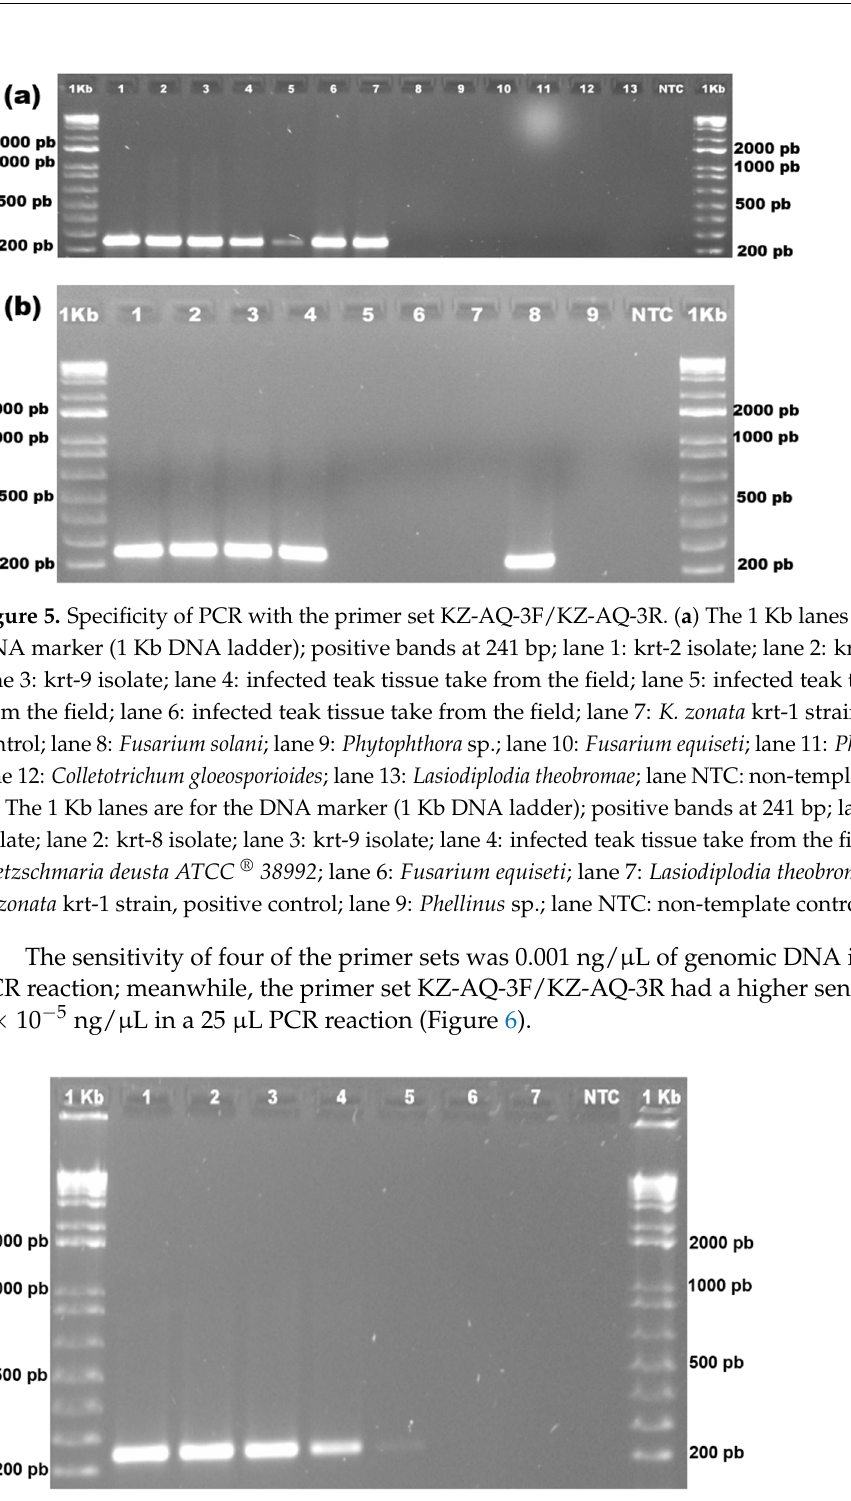
Figure 6. PCR sensitivity assay using the primer set KZ-AQ-3F/KZ-AQ-3R. The 1 Kb lanes are for the DNA marker (1 Kb DNA ladder); positive bands at 241 bp, lanes 1–7: amplified products using genomic DNA of the krt-1 strain at a concentration of: 20, 10, 0.1, 0.001, 1 × 10 − 5 , 1 × 10 − 7 and 1 × 10 − 8 ng/µL, respectively; lane NTC: non-template control.